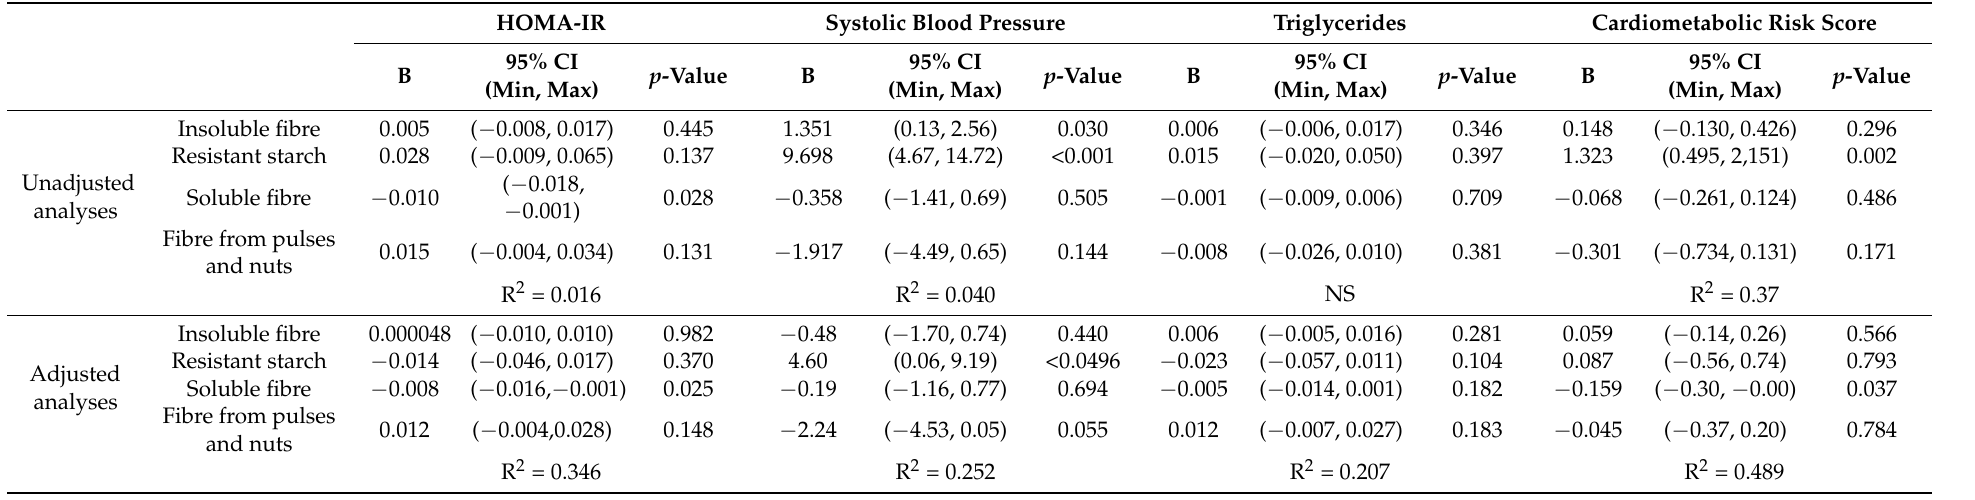
Table 4. Intake of dietary fibre from different sources and cardiovascular health parameters at age 8